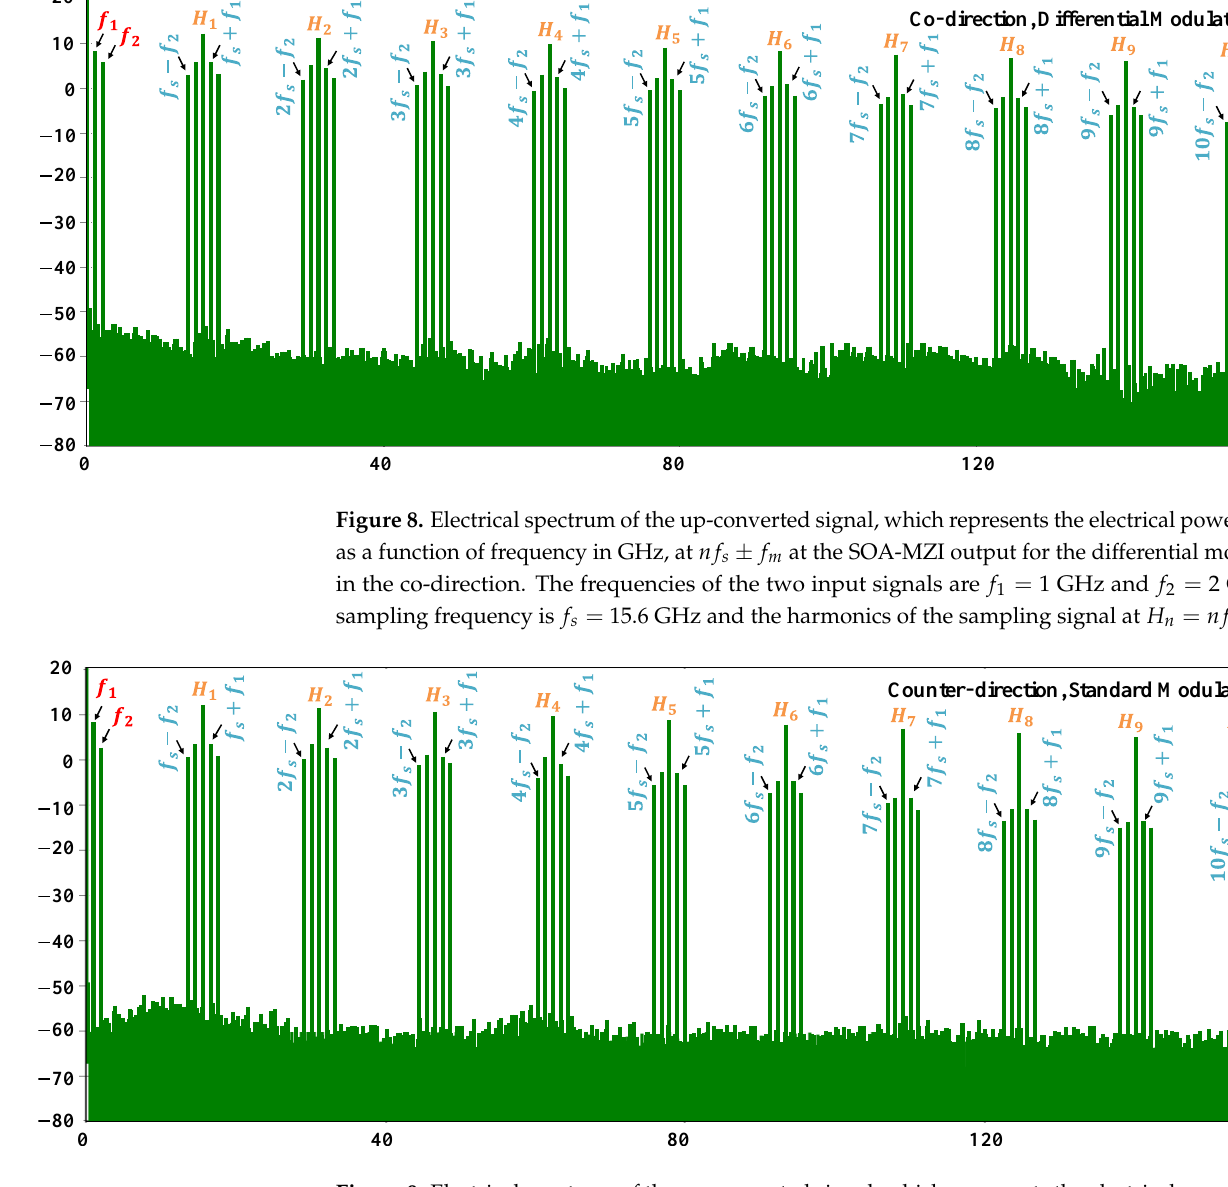
sampling signal at 𝐻 𝑛 = 𝑛𝑓 𝑠 .